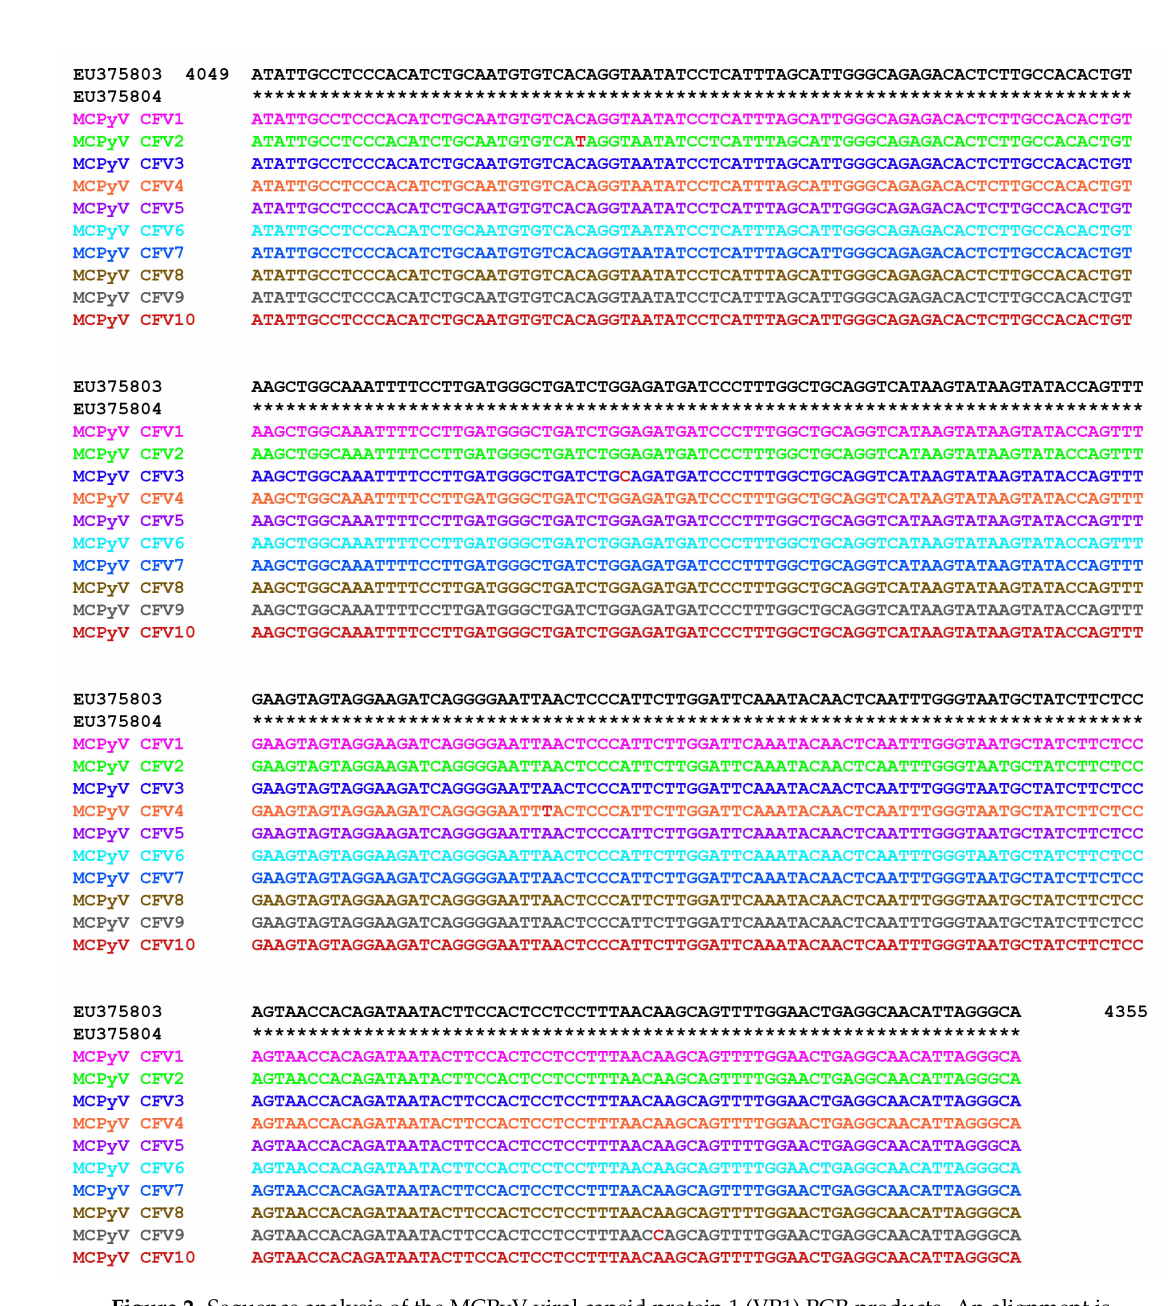
Figure 2. Sequence analysis of the MCPyV viral capsid protein 1 (VP1) PCR products. An alignment is shown between the nucleotide sequence from 4049 to 4355 of the published sequences of MCPyV in GenBank (NCBI) (EU375803; EU375804) [1] and that obtained from the sequencing of oropharyngeal aspirate samples positive for MCPyV VP1 (CFV1 to CFV10). The sequence product study revealed 99% homology with the published sequences. Nucleotide substitutions are highlighted in